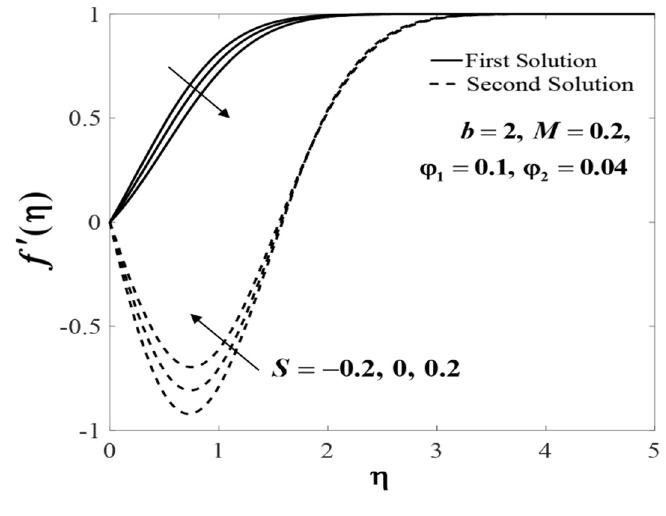
Figure 14. Impact of 𝑆 on 𝑓 ′ (𝜂) .